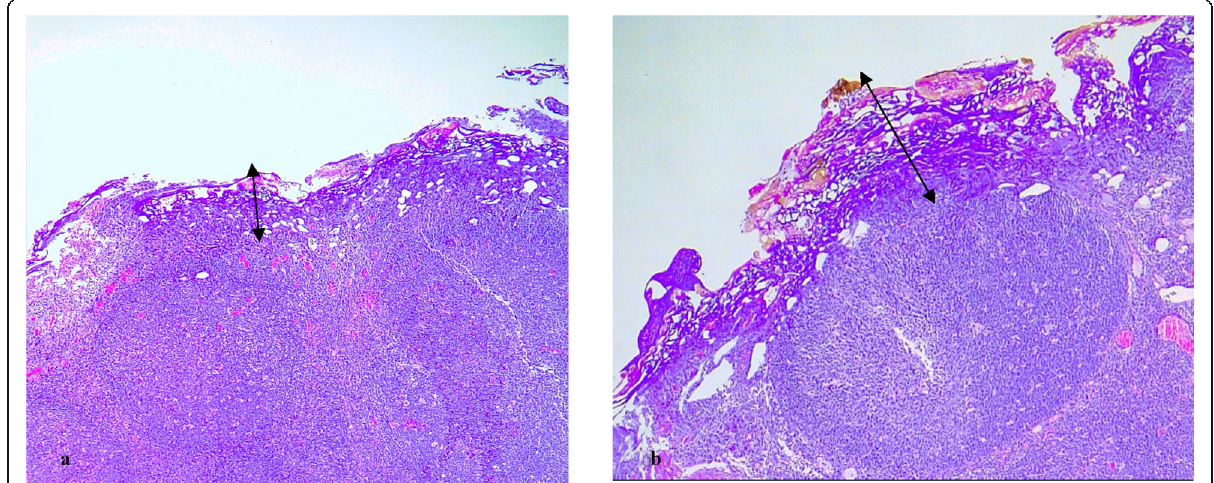
Fig. 1 Thermal injury under light microscopy. The zone of tissue charring, destruction, and vacuolization (double arrows) is more superficial on the 15 W side ( a ) in comparison to the 25 W side ( b ) for the same patient (H&E; × 40)